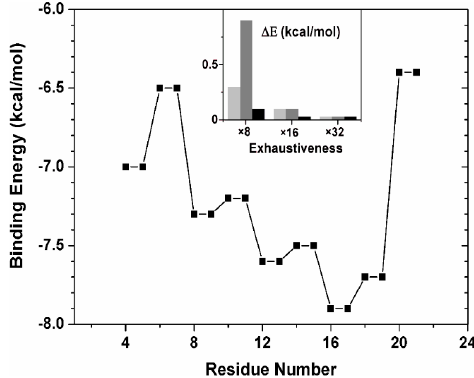
Figure 5. Binding energy of 8-residue-long fragments of NLS-NUPR1L peptide to importin: A ffi nity of each fragment is shown in correspondence of the two residues at the centre of each 8-residue sequence. (Inset) Di ff erence in the binding energy between the docking pose with the highest a ffi nity found at increasing exhaustiveness in the search versus the best pose found at any exhaustiveness value, for three 8-residue-long fragments that together span the whole sequence of the twenty-residue-long NLS-NUPR1L: (light grey) fragment RTRREQAL, (dark grey) RTNWPAPG, and (black) GHERKVAQ.